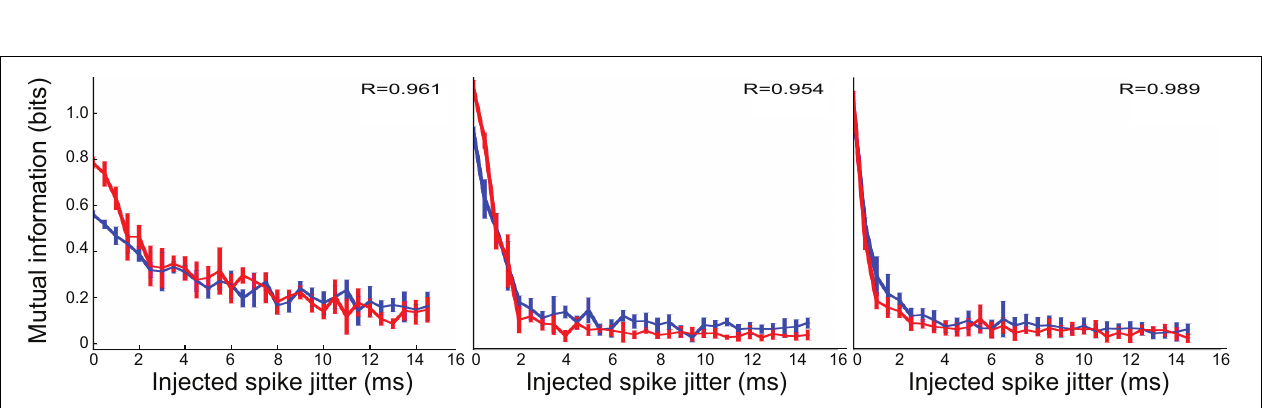
this information measure was higher in the control condition (blue trace) than with inhibition blocked (red trace): blocking inhibition decreased the amount of information per spike .